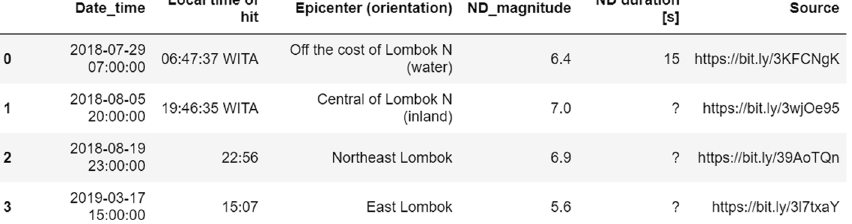
Fig. 21 A dataframe that shows metadata of the four identified earthquake strikes from 2015–2021 in